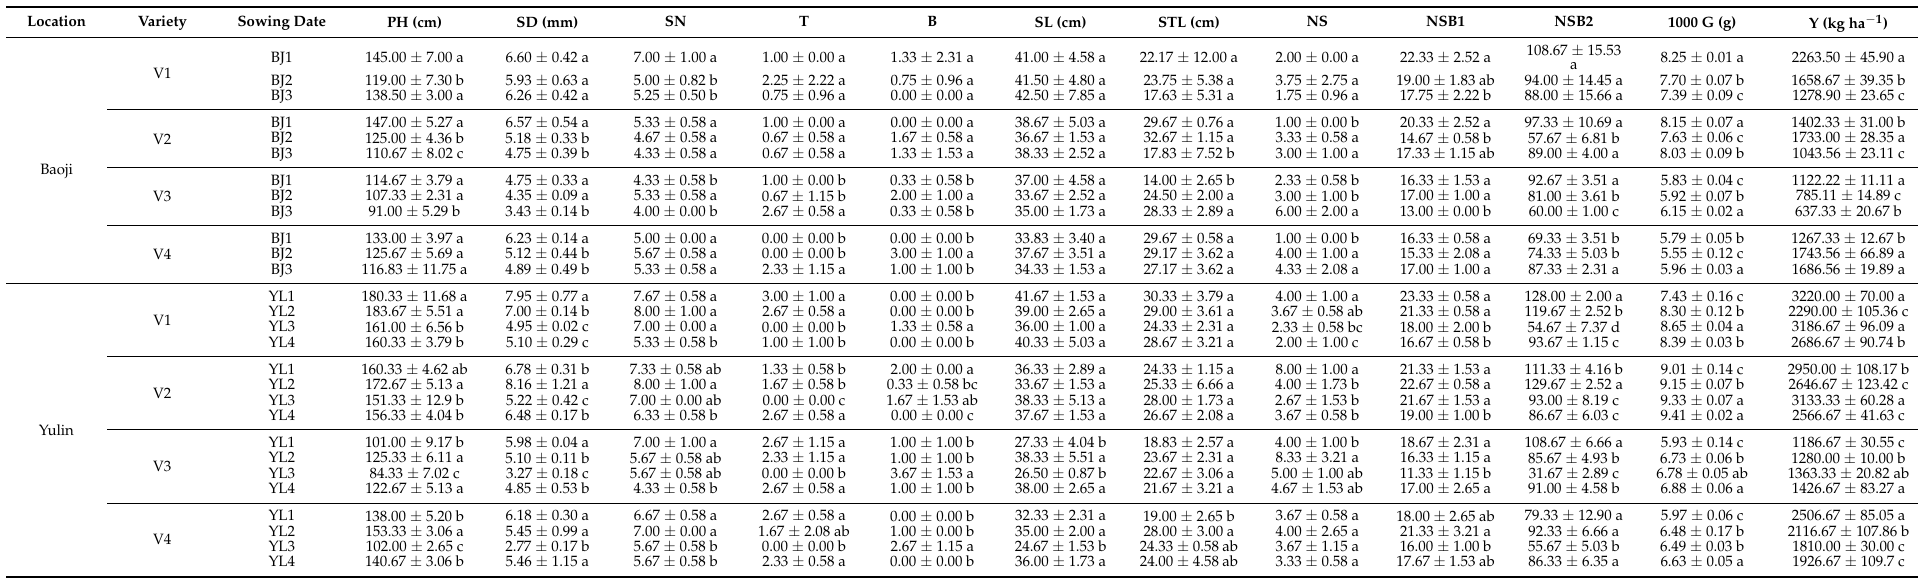
Table 2. Investigation of morphological traits and yield of broomcorn millet under different